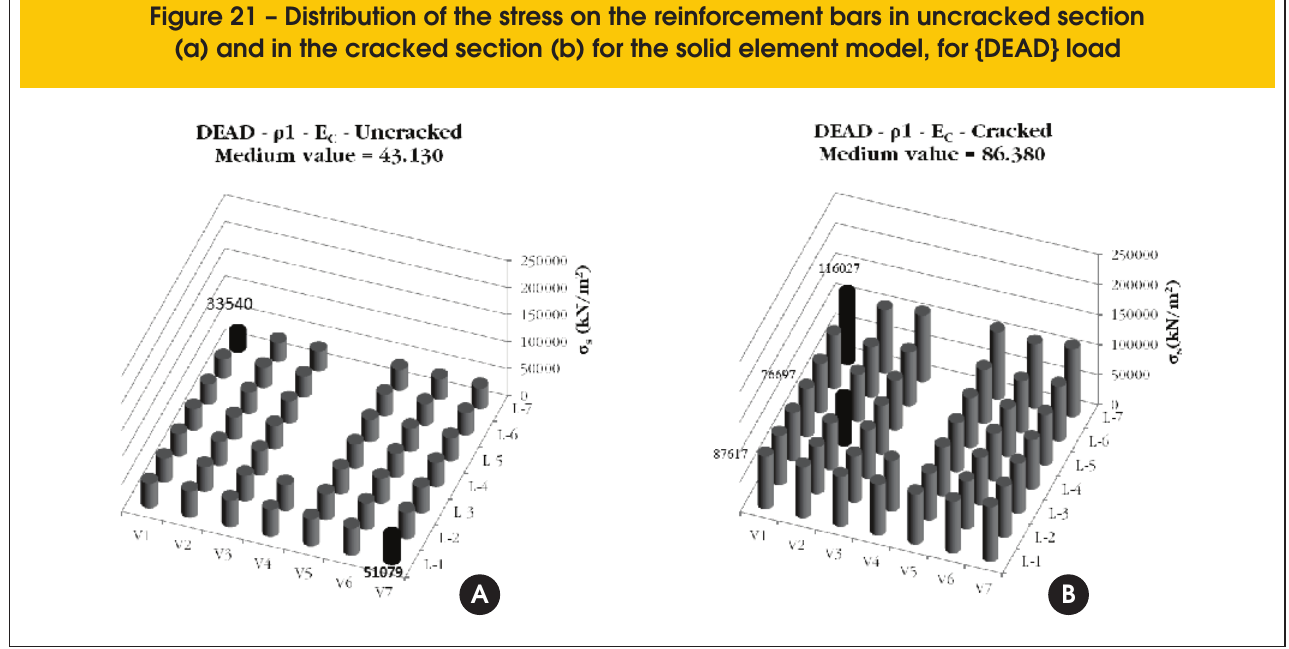
Figure 21 – Distribution of the stress on the reinforcement bars in uncracked section